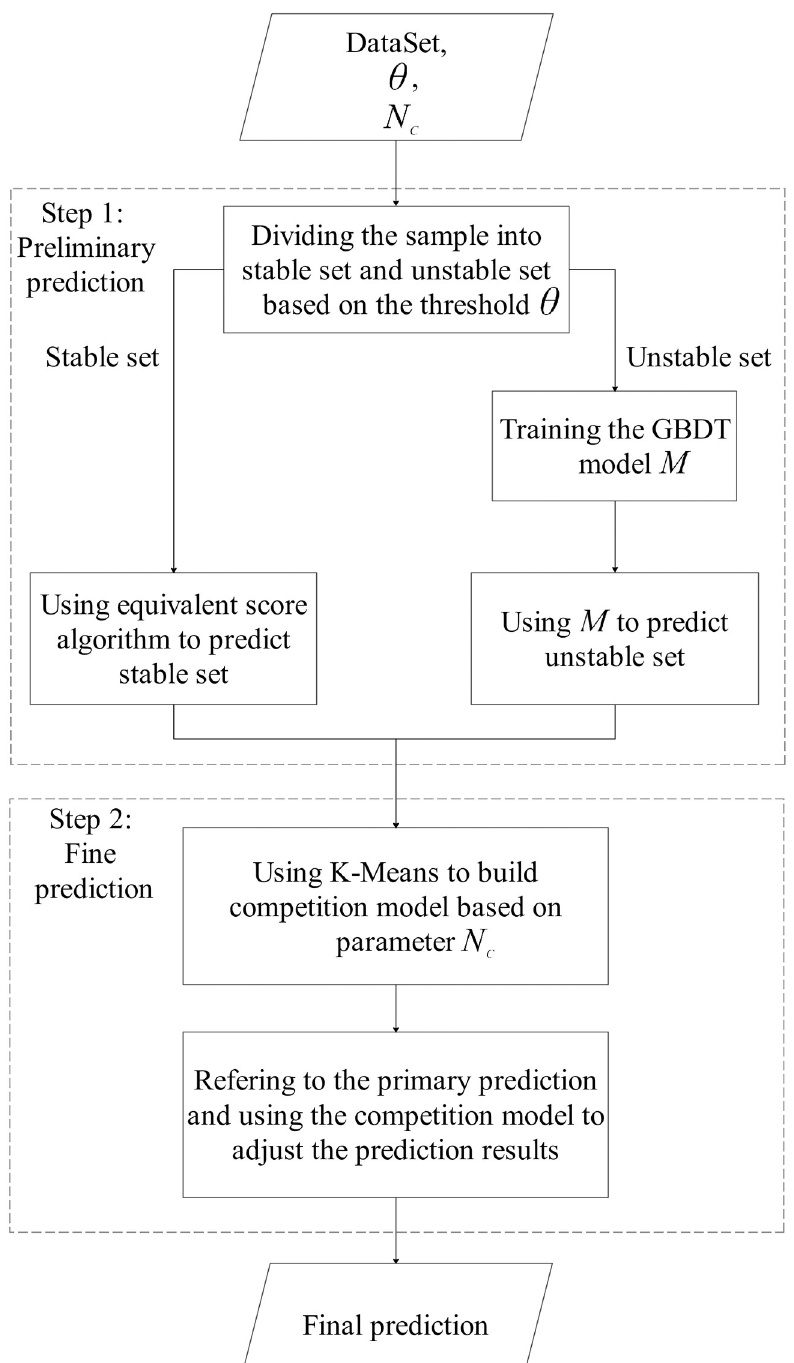
Fig 2. The flowchart of the competition model. It divides the framework into two consecutive steps. In the first step, the task is the preliminary prediction of enrollment rank, and in the second step, the task is the fine prediction of enrollment rank. The predicted admission score is translated from the predicted enrollment rank according to the provincial score-rank comparison table.